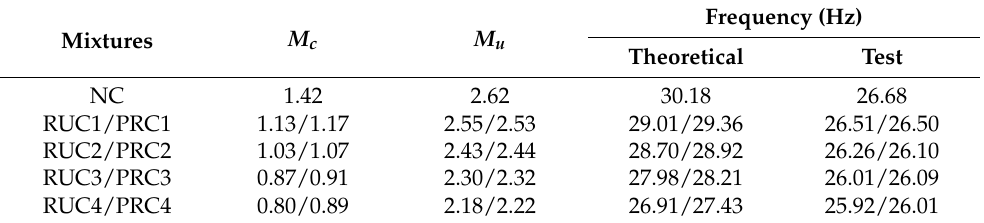
Table 4. Cracking moment, ultimate moment, and natural frequency of cantilever beams.